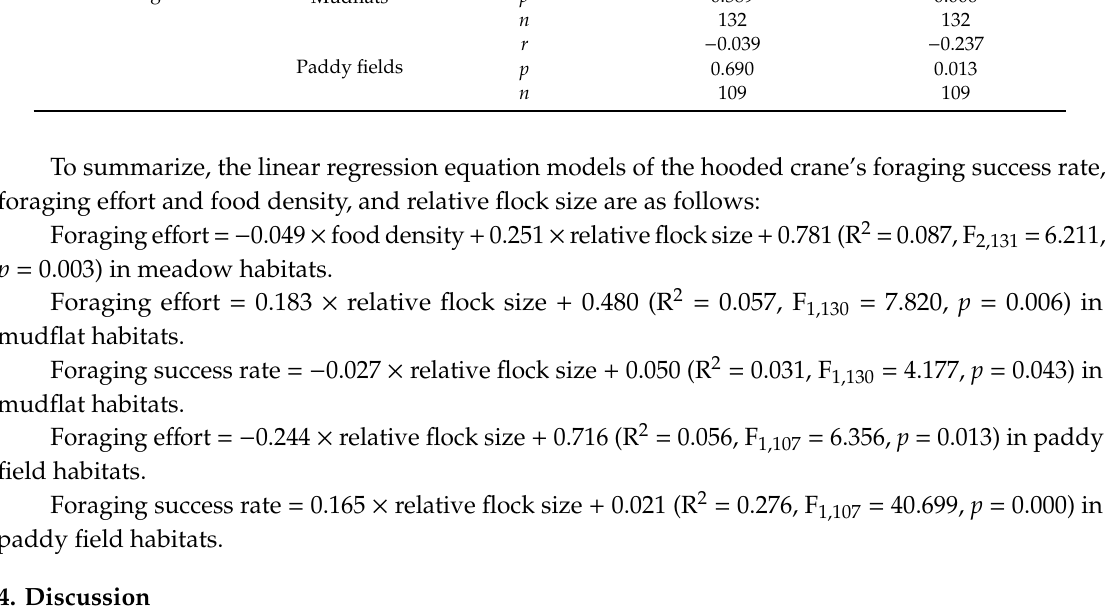
Table 2. The correlation between the foraging e ff ort of hooded crane and the influencing factors at Shengjin Lake. Dependent Variable Habitat Analysis Value Food Density (g / m 2 ) Relative Flock Size r − 0.221 0.258 p 0.010 0.003 Meadows n 134 134 r − 0.076 0.238 Feeding e ff ort p 0.389 0.006 Mudflats n 132 132 r − 0.039 Paddy fields